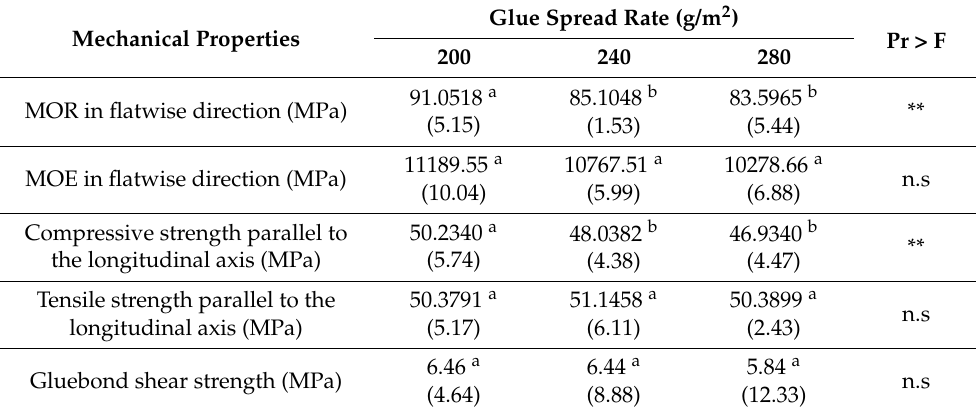
Table 4. Mean values of mechanical properties of rubberwood LVL produced using different glue spread